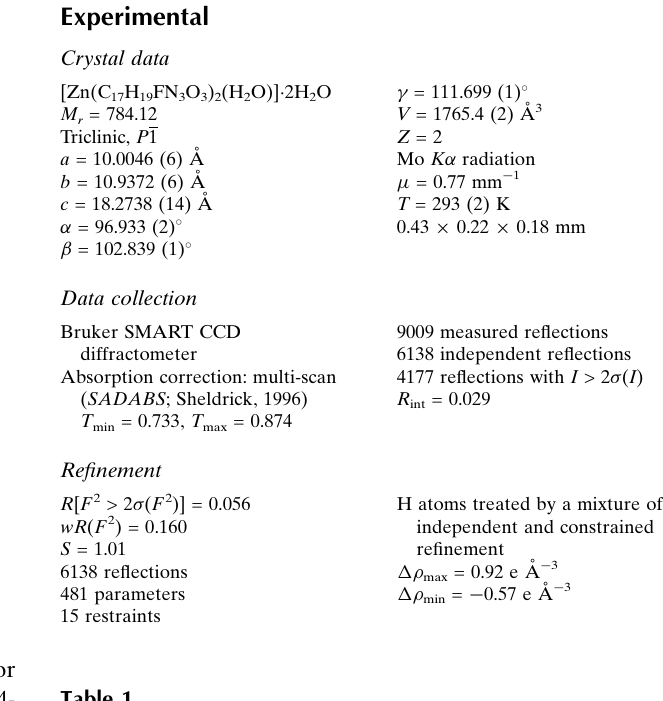
Hydrogen-bond geometry (A˚ , (cid:2)